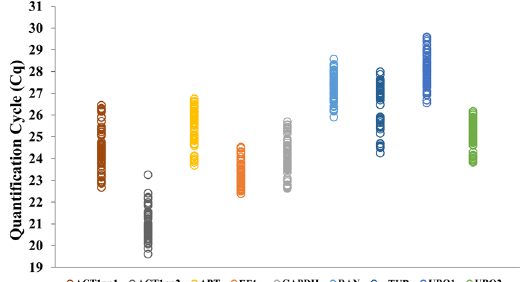
Figure 2. RT-qPCR quantification cycle (Cq) values for tested reference genes. Expression data is displayed as Cq values for each reference gene in leaf material from Musa acuminata genotypes Calcutta 4 and Cavendish Grande Naine, non-inoculated or inoculated with Pseudocercospora musae .